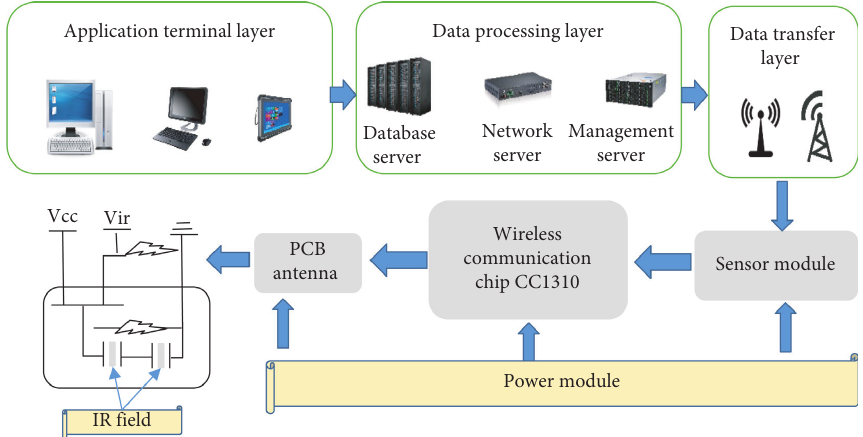
Figure 1: Structure diagram of sensor